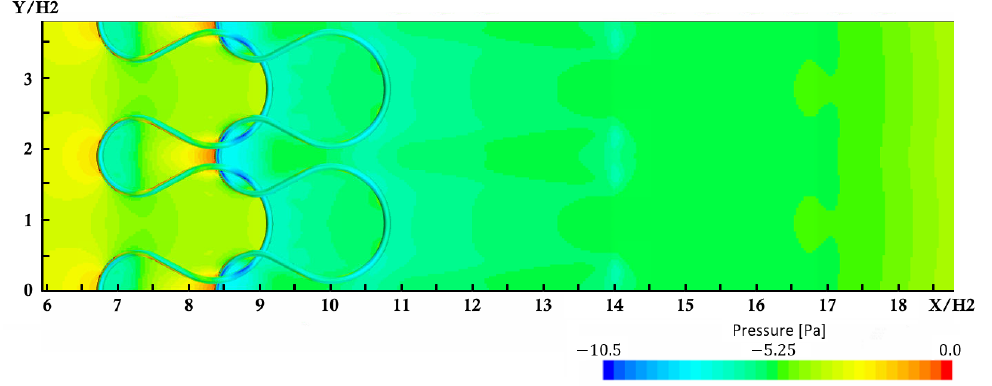
Figure 16. Simulated pressure distribution on the channel wall. The ramp edge is located at X/H 2 =